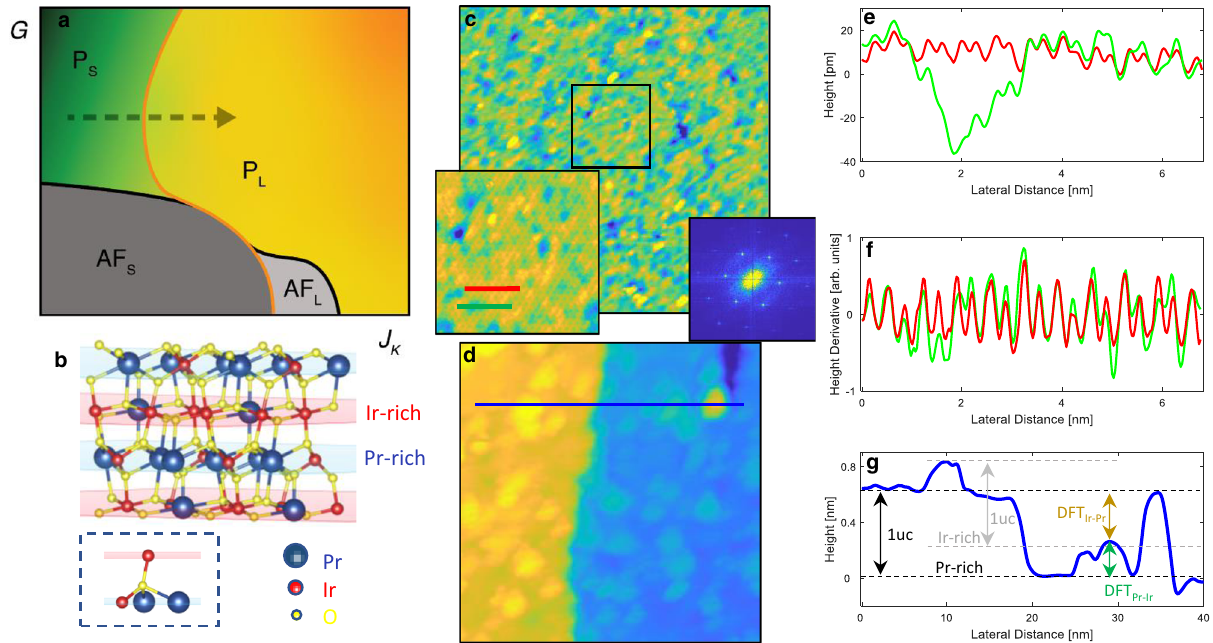
Fig. 1 Crystal structure and topographs of Pr 2 Ir 2 O 7 . a Global phase diagram of frustrated Kondo lattice. P S / P L is the non-magnetic phase with small/large Fermi surface, AF S /AF L is the antiferromagnetic phase with small/large Fermi surface. b Crystal structure of Pr 2 Ir 2 O 7 along the (111) direction highlighting the Pr-rich (light blue plane) and Ir-rich (light red plane) surfaces. The bottom image shows the local atomic environment of an oxygen site between the Ir- and Pr-rich planes with three intralayer and one interlayer oxygen-metal bonds. Based on our DFT calculations, cleaving breaks the single interlayer bond leaving the oxygen atom strongly bonded to its layer. c Topographic image (65 nm, temperature of 33 K, set-point bias of 100 mV, set-point current of 500 pA) of the cleaved (111) surface showing an atomically resolved lattice structure. The left inset is a zoom-in of the black box in the main image, showing more clearly the atomic structure. The right inset is the Fourier transform showing threefold symmetric Bragg peaks. d Topograph (40 nm, temperature of 45 K, set-point bias of 100 mV, set-point current of 500 pA) showing atomically resolved terraces with a step height corresponding to the unit cell in the [111] direction, with small islands observable on the terraces. e Linecuts of the topograph along the red and green lines in the left inset of c . f Height derivative of the linecuts in e indicating no missing atoms. g Linecut along the blue line in the topograph in d , showing the main terraces formed by a Pr-rich surface and the islands formed by the Ir-rich surface. The dashed horizontal lines and vertical arrows represent the DFT step heights between the Pr- and Ir-rich